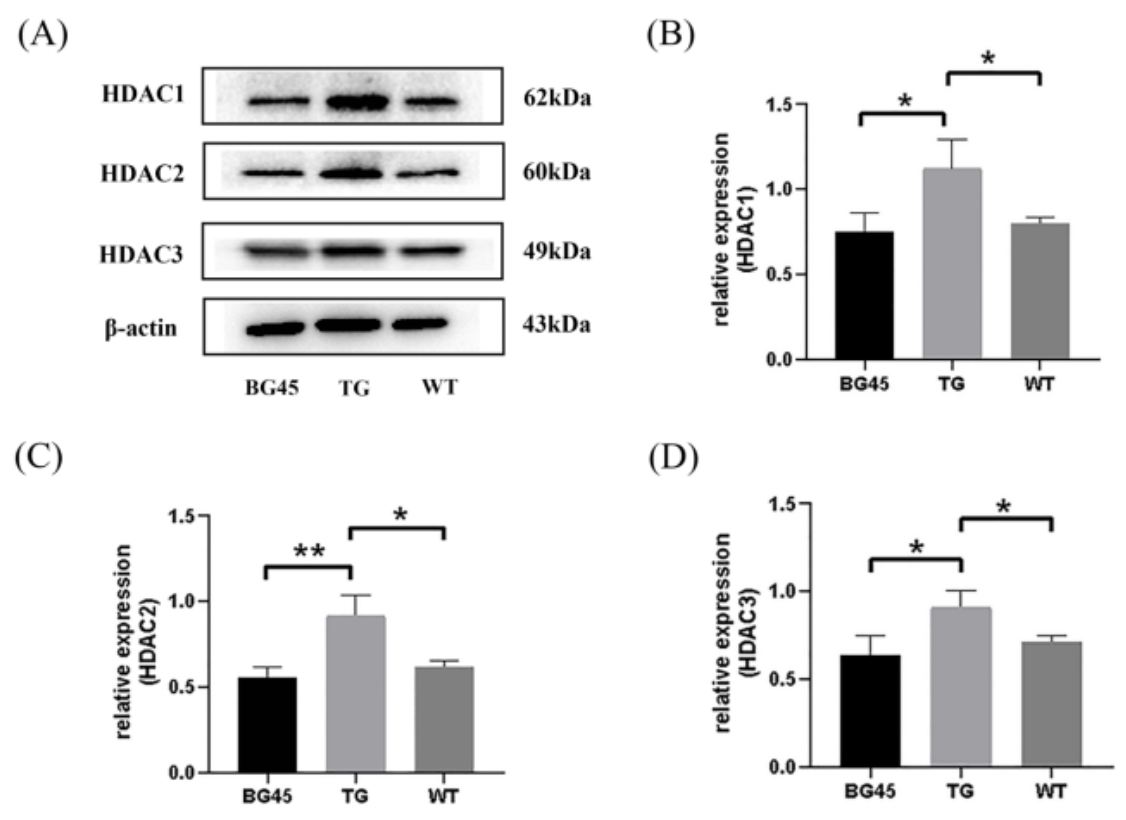
Figure 5. Effects of BG45 on class I HDACs (HDAC1, 2, and 3). ( A ) Representative protein expression bands of HDAC1, HDAC2 and HDAC3. ( B ) Quantification of HDAC1 expression. ( C ) Quantification of HDAC2 expression. ( D ) Quantification of HDAC3 expression. The values are presented as the mean ± SD from three independent experiments. * p < 0.05, ** p < 0.01.